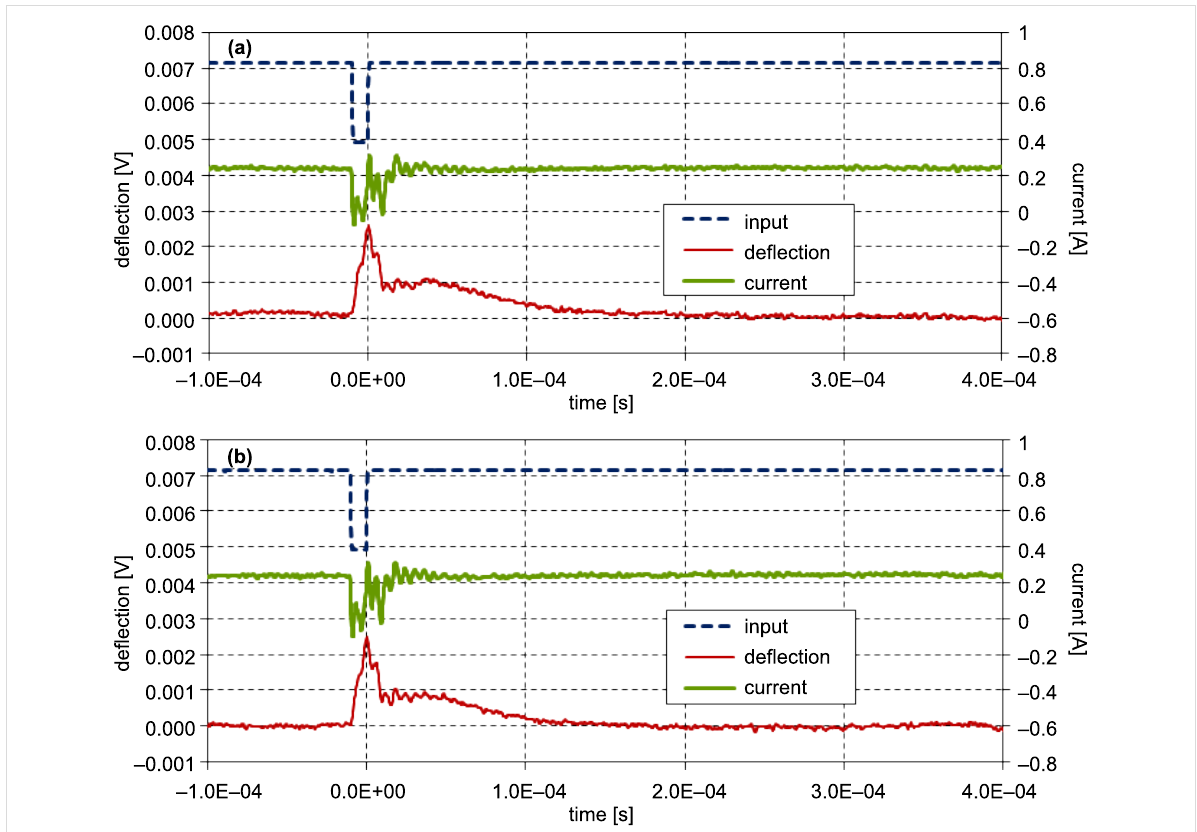
Figure 5: Comparison of pulse responses recorded at 300 nm from the substrate (a) and in close proximity (b). The fine broken, thick solid, and fine solid lines indicate the input-voltage signal, current in the electromagnet, and cantilever deflection, respectively. The cantilever swings toward the sub- strate with an amplitude of about 1 nm.